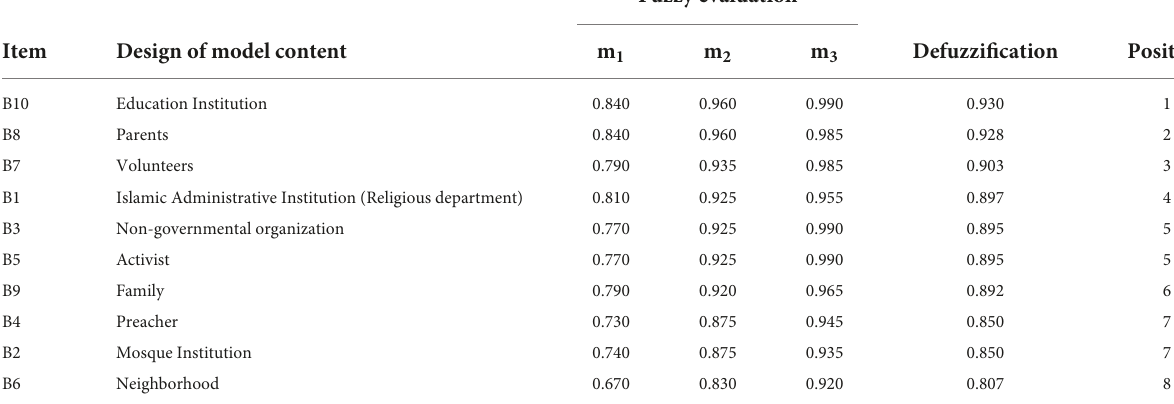
TABLE 6 Fuzzy evaluation on construct two: Access to support to learn religion for children with learning